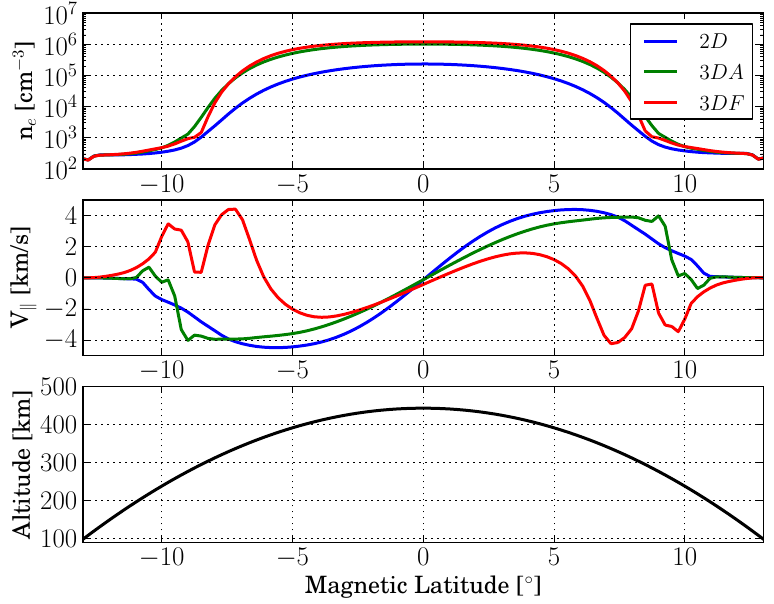
Fig. 3. (Top) Plasma densities and (middle) O + ion parallel velocities along the flux tube that intercepts the top of the plasma irregularity ( ∼ 440km apex altitude) for the (blue) 2-D, (green) 3-D-A, and (red) 3-D-F models. The bottom panel depicts the equivalent altitude (in km) at a given